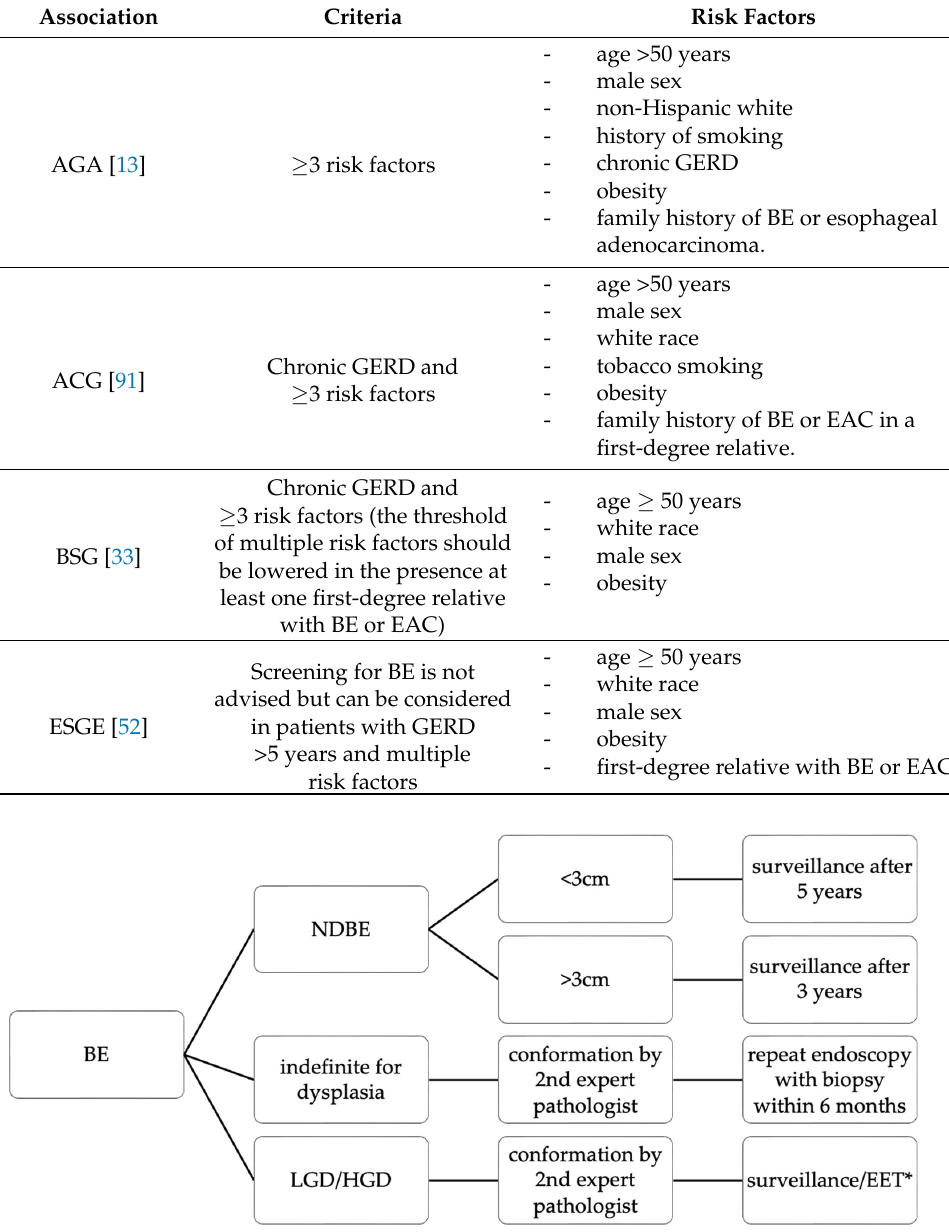
Figure 1. Care algorithm for patients with diagnosed BE ‐ based on ACG guidelines [91]. * Precise recommendations on the management of LGD and HGD can be found in Table